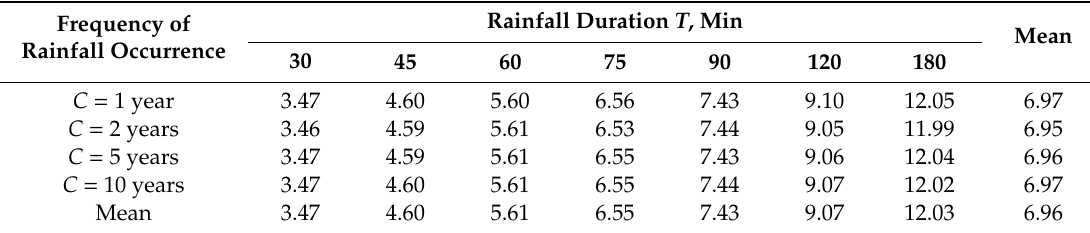
Table 3. The values of the n i indicator for Euler type II